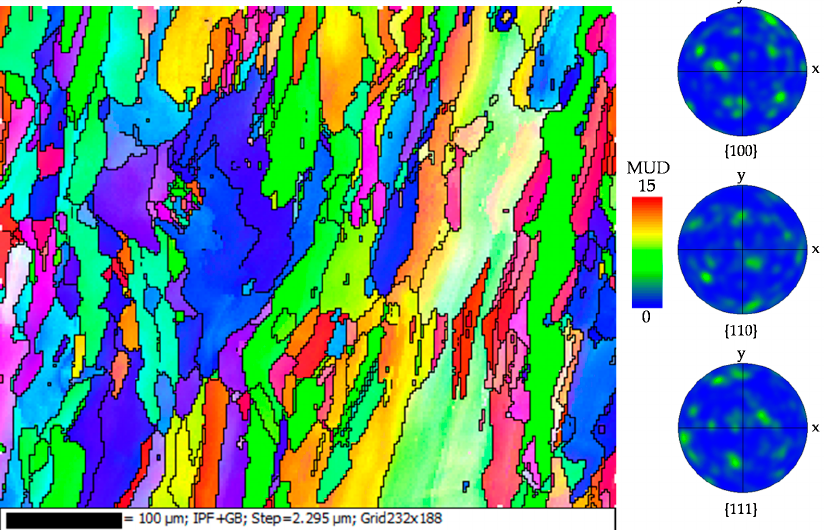
= 133 W, v = 80 mm / s, ∆ y = 60 µ m, T s L